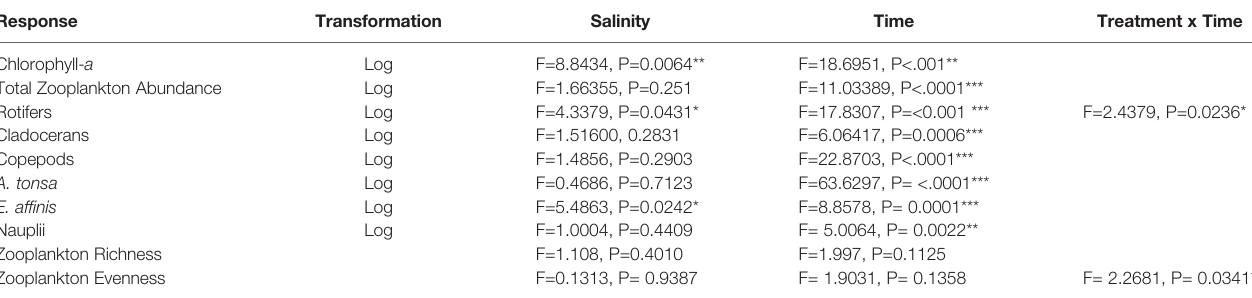
TABLE 1 | Results of the mixed effect models for response variables with salinity, time, and their interaction.